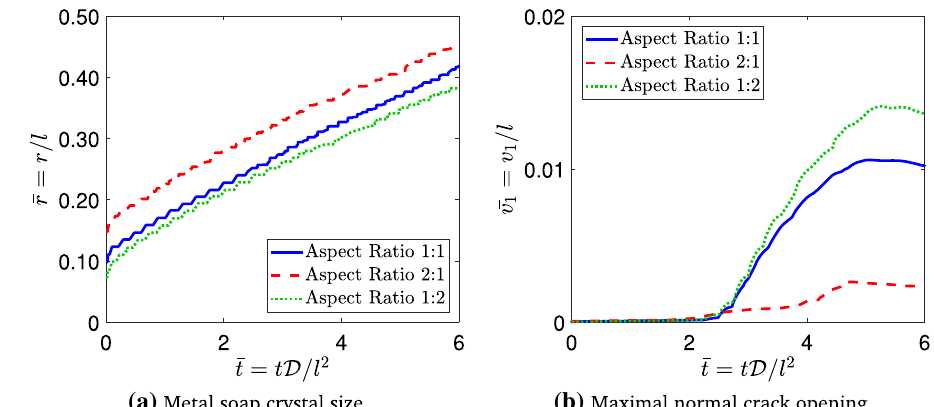
Fig. 5 Influence of the initial nucleus aspect ratio on the time evolution of a the metal soap crystal size ̄ r (with ̄ r being the average radius of the crystal) and b the maximal normal crack opening ̄ v 1 of the predominant